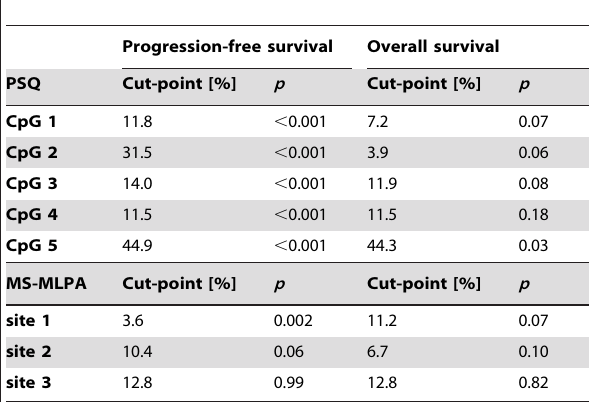
Table 2. Estimated cut-points for PSQ and